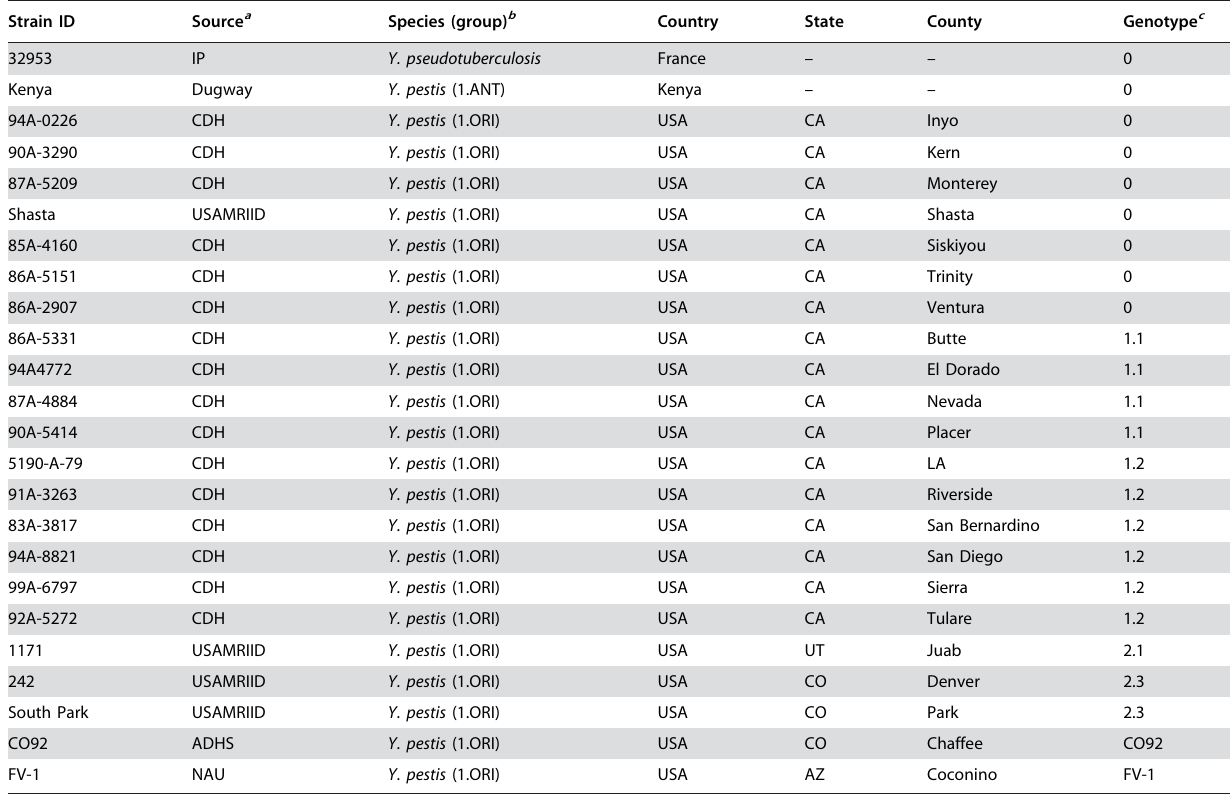
Table 2. Twenty-four Yersinia spp. strains used to screen FV-1/CO92 SNPs. .. ... .... ... ... .... ... ... .... ... ... .... ... ... .... ... ... .... ... ... .... ... ... .... ... ... .... ... ... .... ... ... .... ... ... .... ... ... .... ... ... .... ... ... . Strain